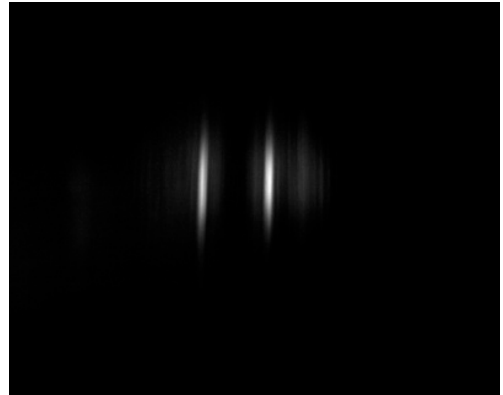
Figure 5. Measured far field distribution at a distance of 5.5 cm behind the SLM after optimizing the axicon parameters for configuration Com 1 (field of view: 7.03 × 5.62 mm 2 ). The distance between the maxima is 953 µm.